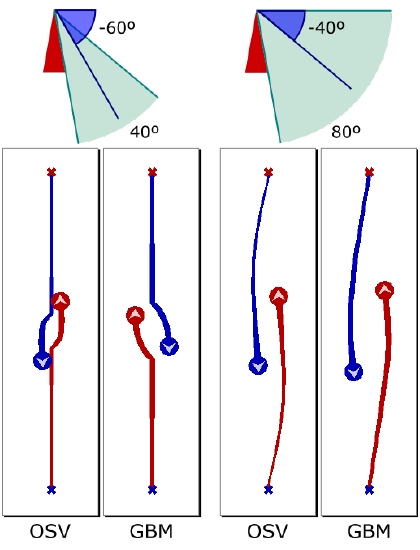
Figure 9. The image shows how the agents behave in a simple scene varying the top plane inclination. In the first two columns, it is shown the execution for the vertical angle of 40 ◦ and rotation of for OSV and GBM. The last two columns represent the agent trajectories when the angles have the default values of 80 ◦ and